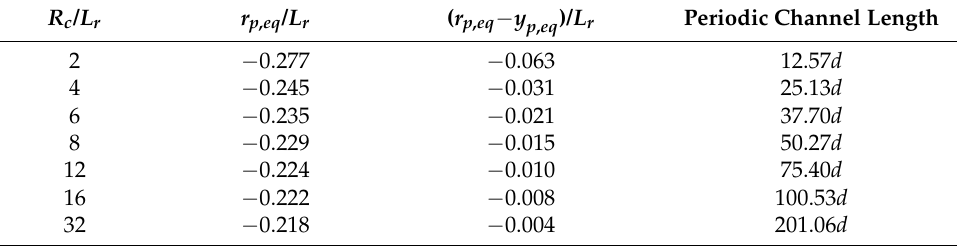
Table 3. Equilibrium position at each radial length of curvature and periodic channel length.